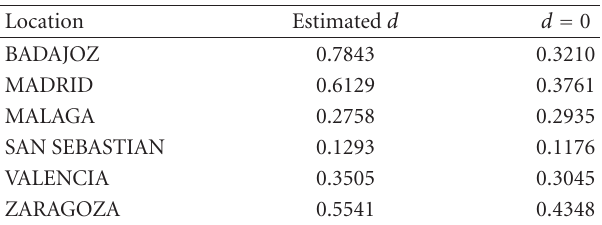
Table 7: Annual increase in the temperatures (in 0.1 ◦ C) using the same sample size. Series: T max .